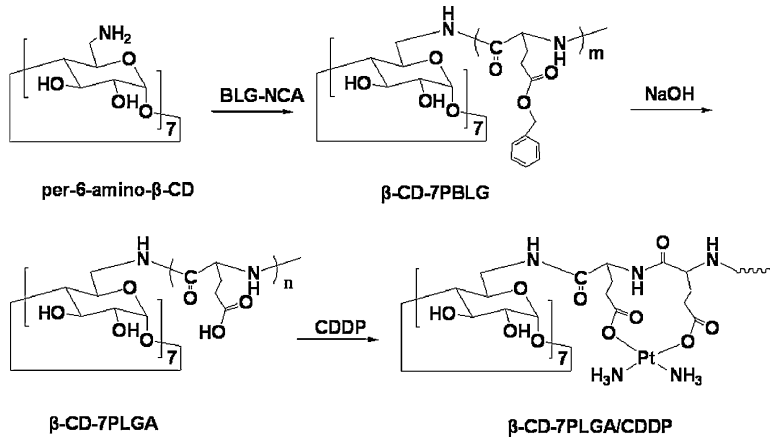
Figure 38. Synthesis scheme of β -CD-7PBLG, β -CD-7PLGA and β -CD-7PLGA/CDDP complex. Reproduced with permission from reference [185].